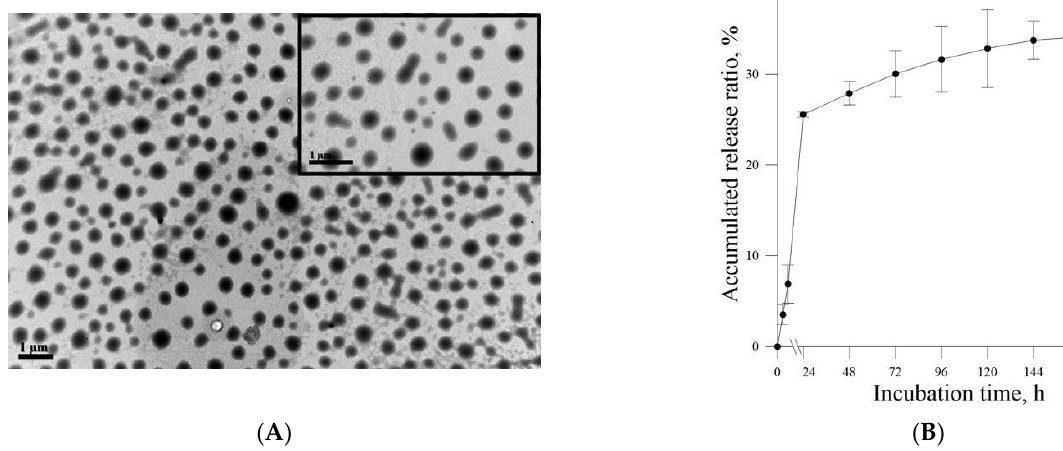
Figure 1. ( A ) Transmission electron microscopy images of Lipo-Farn. The diameter of the liposomes was 342 ± 90 nm. ( B ) Farn release profile from Lipo-Farn. The release rate of Farn was 26% after 24 h of incubation.